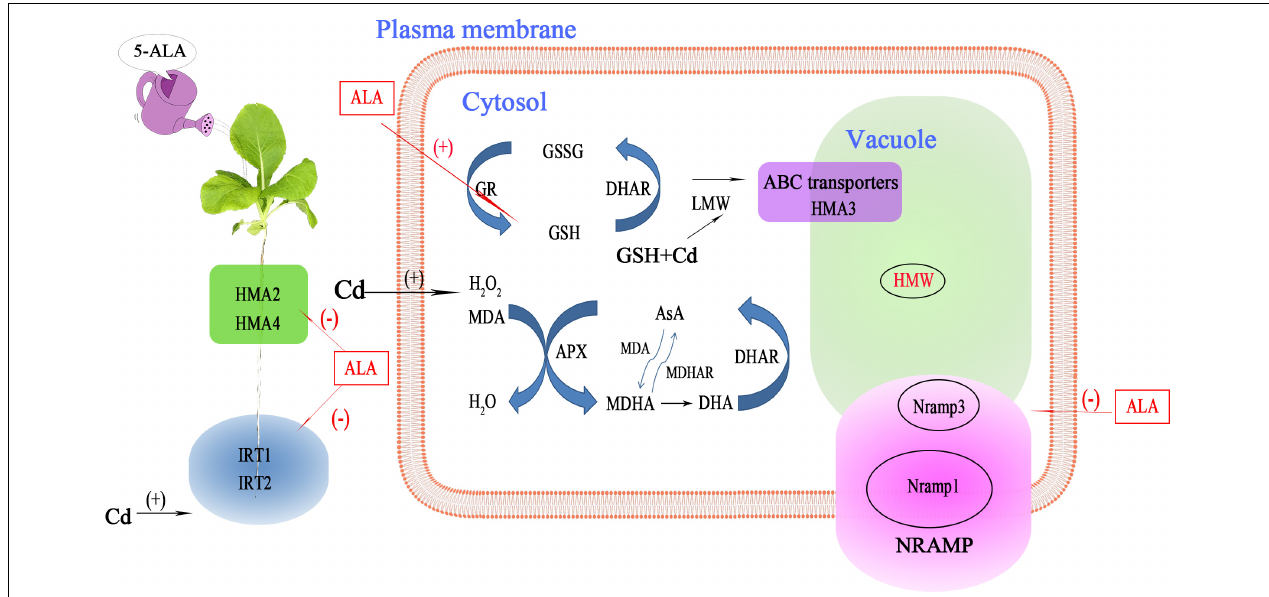
FIGURE 10 | A model illustrating the role of ALA in Chinese cabbage seedlings’ tolerance to Cd stress. Cd stress increased the content of MDA and H 2 O 2 in Chinese cabbage seedlings. The ALA can increase the enzyme activities of the antioxidant system, induce a large amount of GSH and AsA, and remove ROS and Cd ions in plants. Meanwhile, ALA downregulates the expression of the Cd absorption and transportation-related genes ( HMA2, HMA4, Nramp1, and Nramp3 ), which ultimately leads to a decrease in Cd level and an increase in resistance to Cd stress. This process increases the tolerance of Chinese cabbage to Cd. (+) Positive regulation; (–) Negative